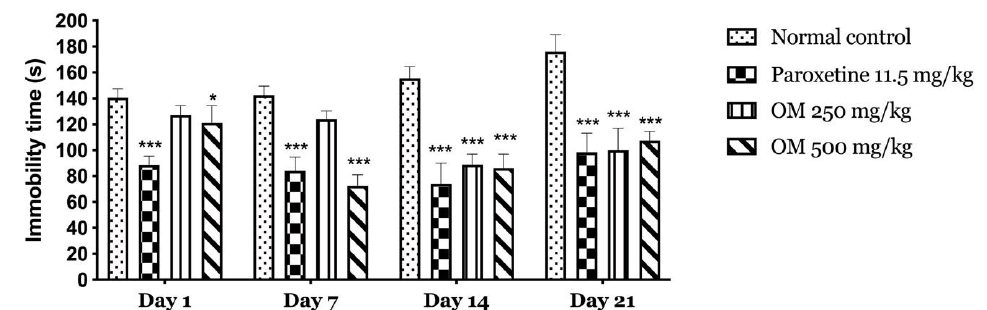
Figure 2. Effects of OM on the Forced Swimin Test test in mice on the 1st, 7th, 14th, and 21st days. Values are expressed as mean ± SEM. The analysis was done using two-way repeated-measures analysis of variance followed by Dunnett post hoc test *** p < 0.001, * p < 0.05 compared with normal control.